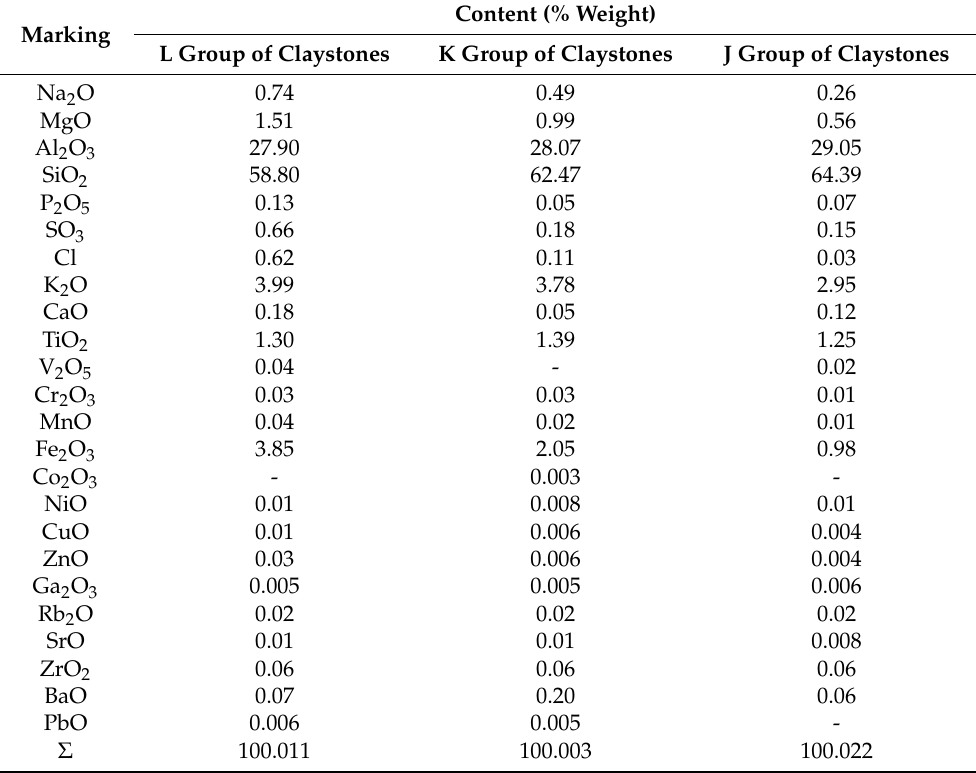
Table 2. Results of the claystone chemical analysis.